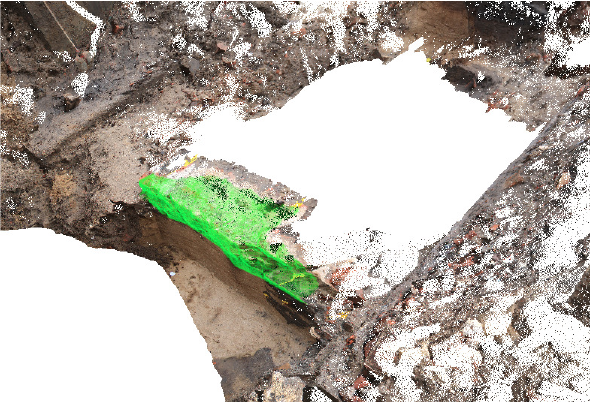
Figure 8: 3D presentation of a selected region of interest in a point